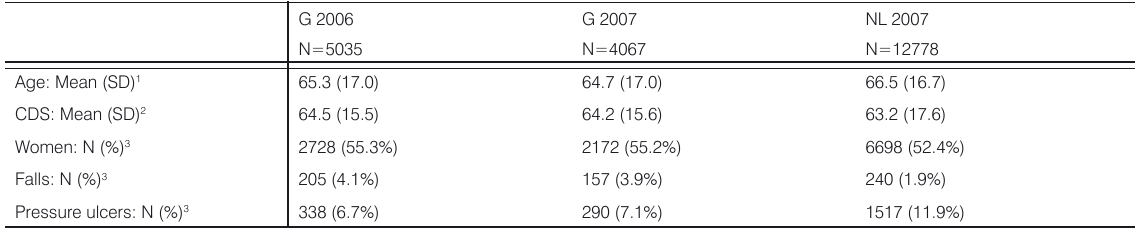
Table 2. Characteristics of the samples from Germany 2006 (G 2006) and 2007 (G 2007) and the Netherlands 2007 (NL